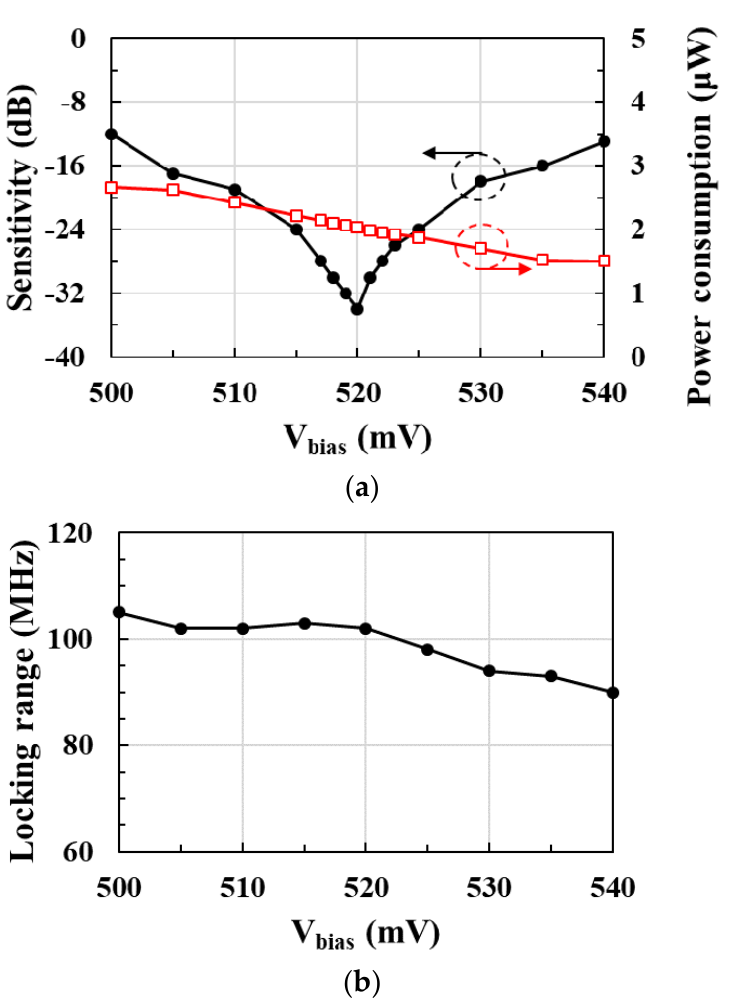
Figure 4 . ( a ) Input sensitivity and power consumption; ( b ) locking range of the RF clock harvester according to the gate bias voltage V bias of the PMOS current source.